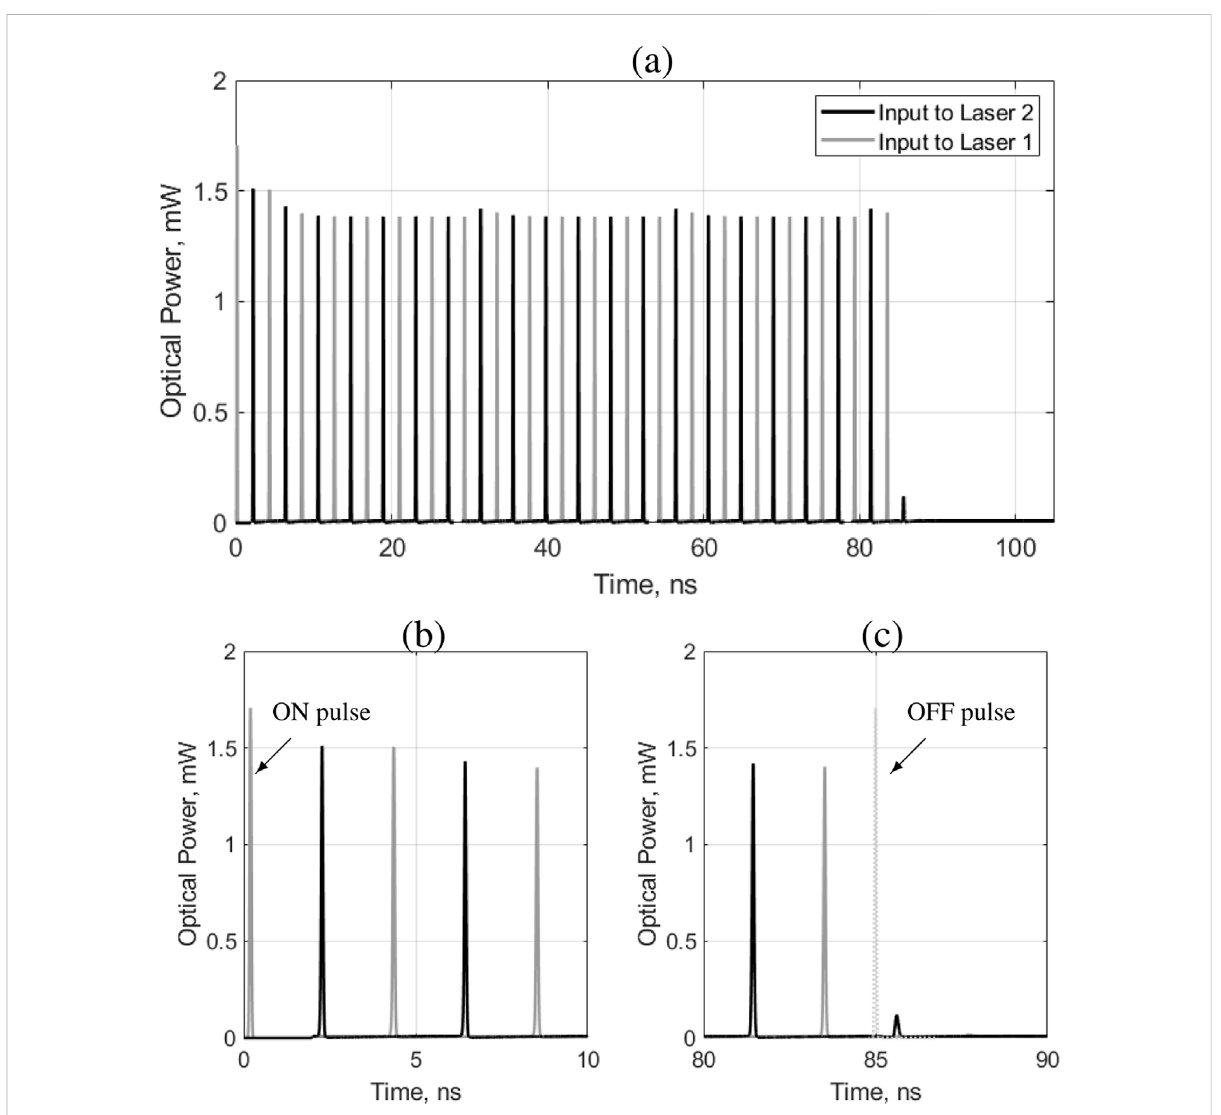
FIGURE 11 (A) :Pulsetrainfromtwoself-coupledlaserneuronswith2nsdelayand7 dBofopticalgain.Gray:inputtolaser1SAsection.Black:inputtolaser 2 SA section. (B) : focus on the start of the pulse train. (C) : focus of the end of the pulse